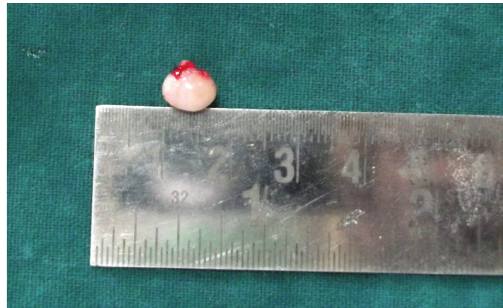
Figure 2: The excised mucocele tissue.